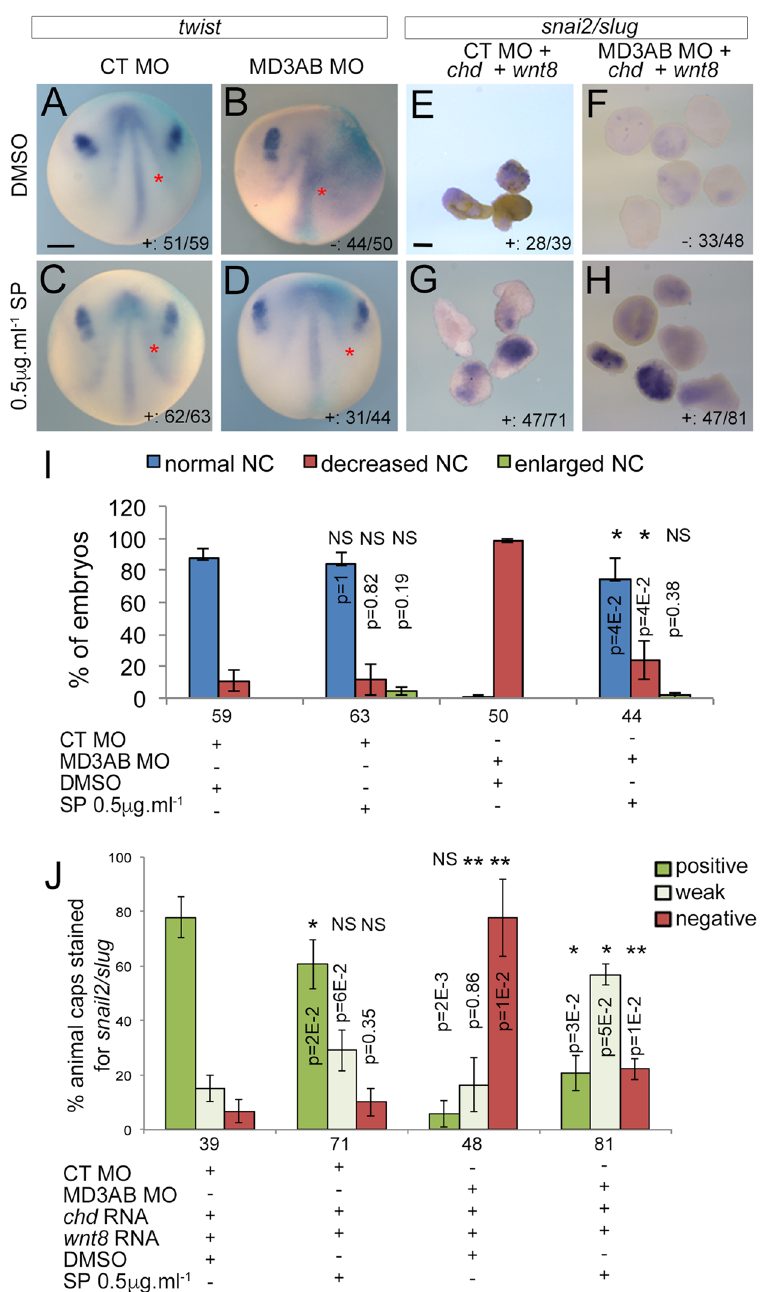
Figure 9. Rescue of neural crest formation by small molecule inhibitor for JNK in MarvelD3 depleted embryos. Neural crest induction (stage 15) was analysed by WISH against twist in control and MD3AB morpholino-injected embryos (A – D ; red asterisk, injected side of the embryo with β -galactosidase staining) and against snai2/slug in animal caps explants co-injected with chd mRNA + wnt8 mRNA + control morpholino or chd mRNA + wnt8 mRNA + MD3AB morpholinos. Both embryos and animal caps were treated from stage 11 to 15 with DMSO or 0,5 μ g.ml − 1 SP600125, a JNK inhibitor ( E – H ). Neural crest induction was quantified according to twist or snai2/ slug expression in embryos ( I ) and animal caps ( J ), respectively. Mann-Whitney test p values and the number of embryos or animal caps analysed are indicated; red asterisk, injected side of the embryo with light blue β -galactosidase staining. ( I ) blue bar, normal neural crest; red bar, reduced neural crest; ( J ) dark green bar, positive; light green bar, weak; red bar, negative snai2/slug staining. + , embryos or animal caps positive or weak for twist or snai2/slug expression; -, embryos or animal caps negative for twist or snai2/slug expression. Scale bars, 500 μ